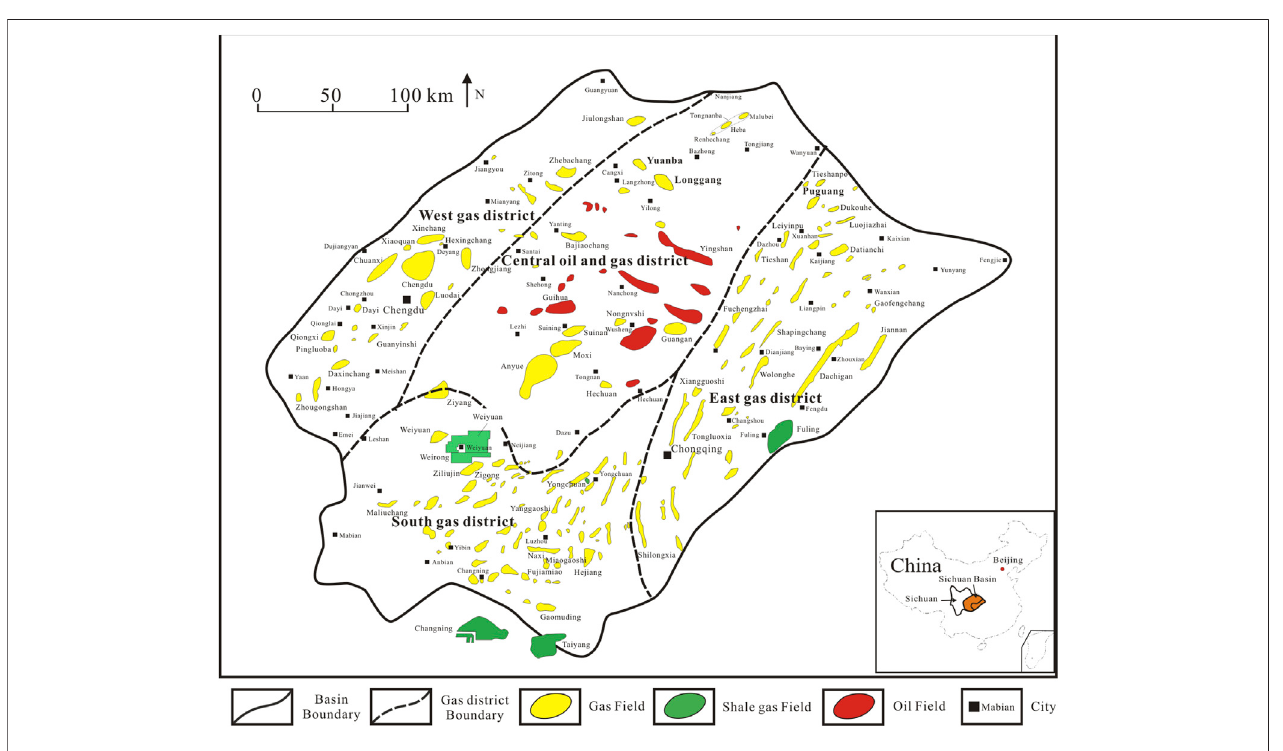
FIGURE 2 | Distribution of oil and gas fi elds in the Sichuan Basin (Modi fi ed after Ni et al., 2021).